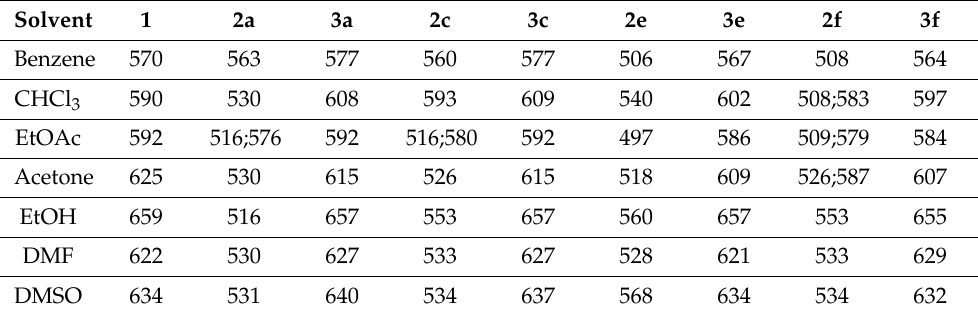
Table 3. Fluorescence maxima (in nm) of obtained derivatives in various organic solvents.